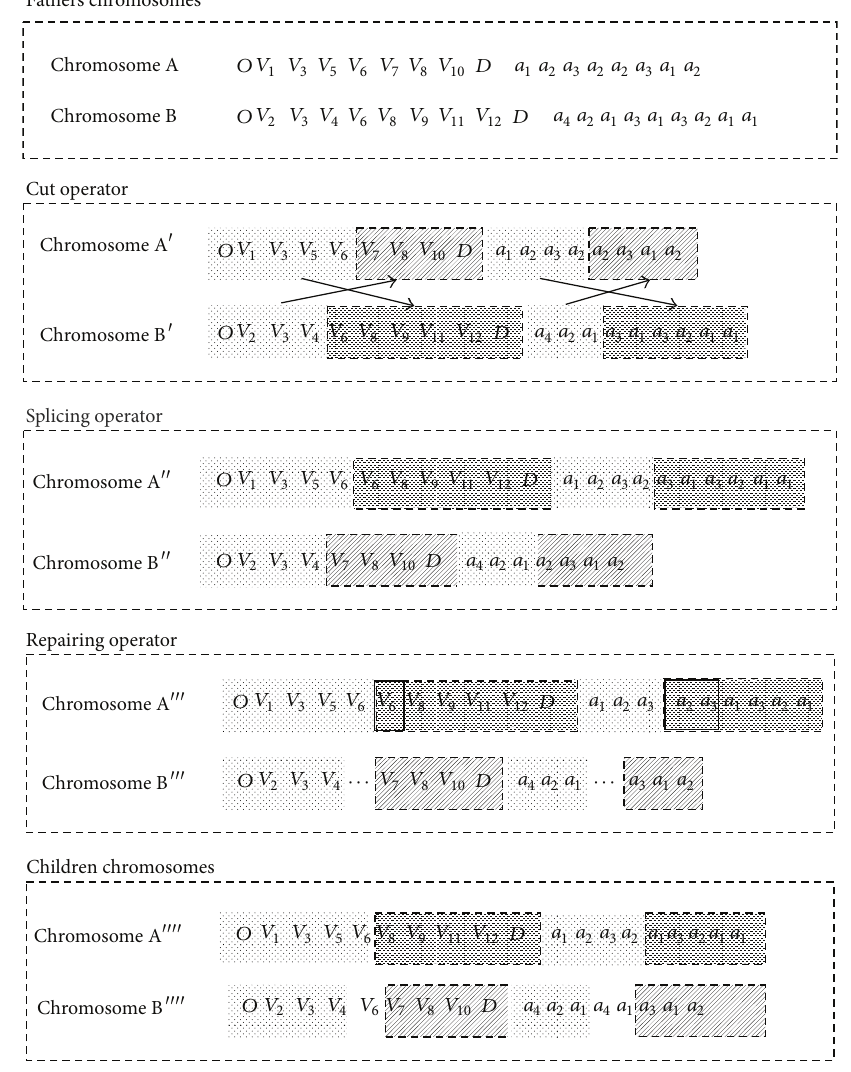
Figure 2: Crossover operation.